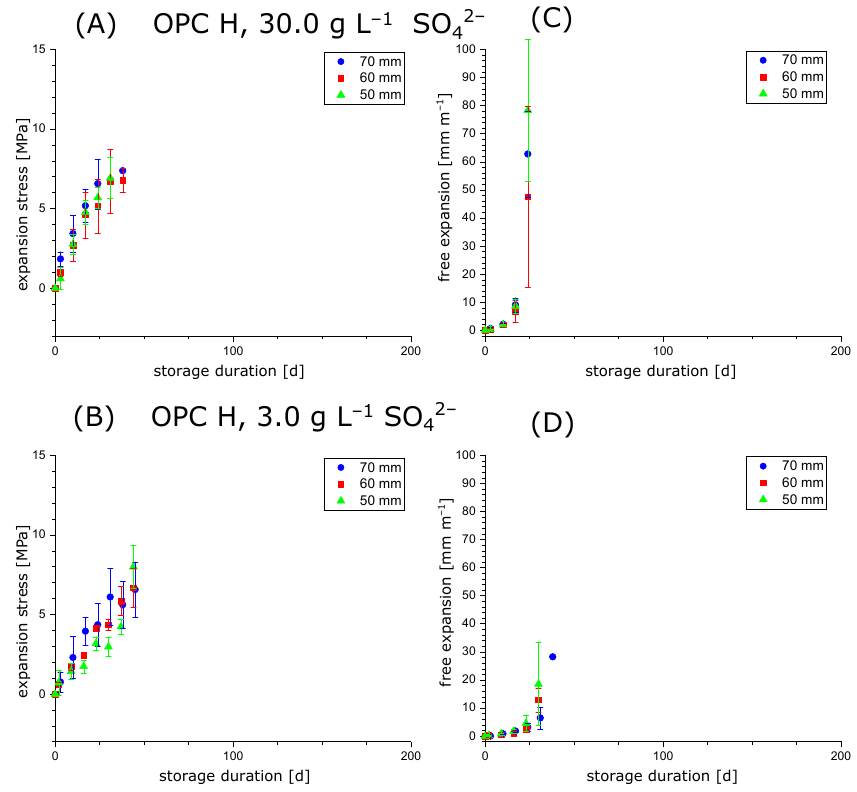
Figure 5. Expansion experiments (sodium sulphate solution, 30.0gL SO 2– 4 or 3.0gL SO 2– 4 ) for hollow cylinders with varying diameter/length ratio prepared with OPC H. The samples were stored until their mechanical failure due to the formation of macroscopic cracks. ( A , B ) Expansion stress (stress cell with steel rod). ( C , D ) Free expansion (stress cell with steel